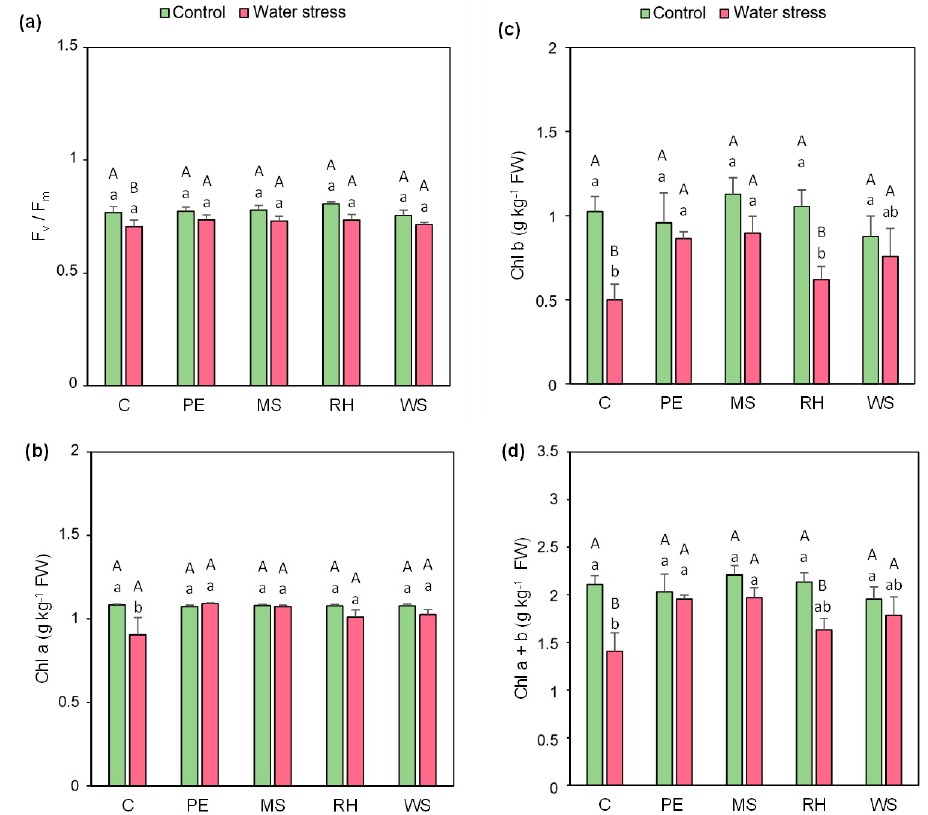
Figure 3. ( a ) Chlorophyll fluorescence (F v /F m ), ( b ) chlorophyll a, ( c ) chlorophyll b, and ( d ) total chlorophyll (a + b) in the leaves of escarole plants of the commercial variety “Brillantes” non-mulched or subjected to different mulching treatments and cultivated under control (well-watered) and water stress (70% ETc) conditions. Bars show the means of five plants ± standard error. Different capital letters indicate significant differences due to the water stress treatment while different small letters show significant differences among mulching treatments according to Tukey’s test ( p ≤ 0.05). Abbreviations used: non-covered substrate (C), polyethylene mulch (PE), mushroom substrate-based